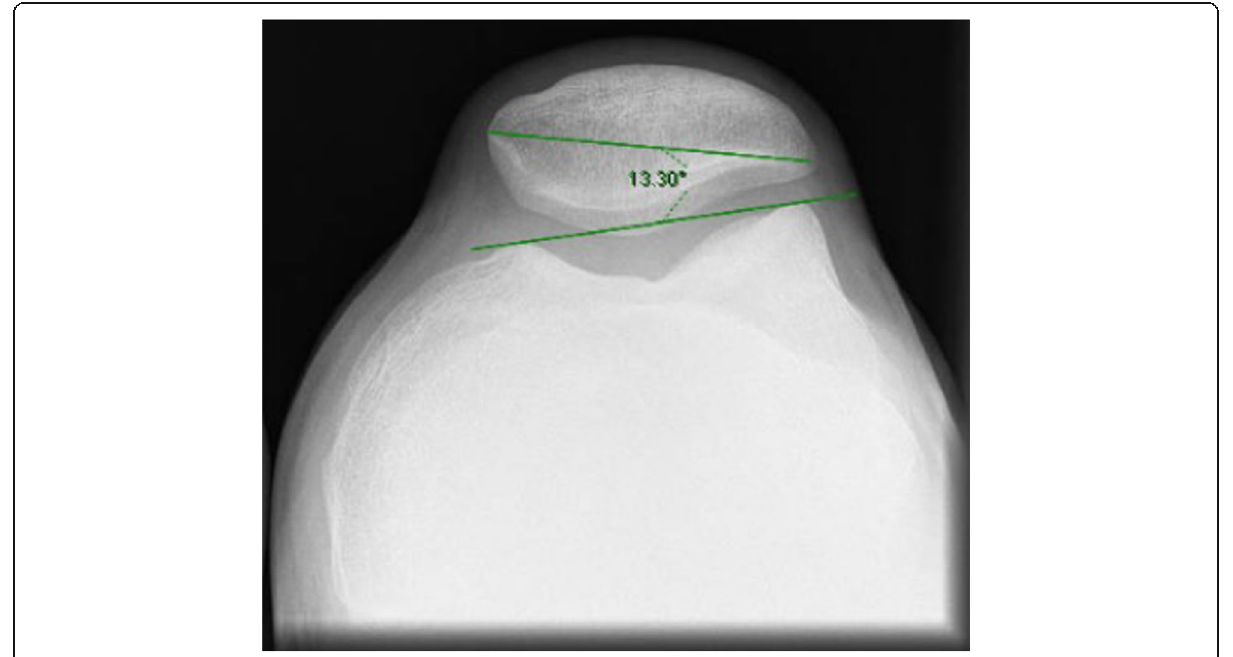
Fig. 2 Measurement of the Lateral Patellar